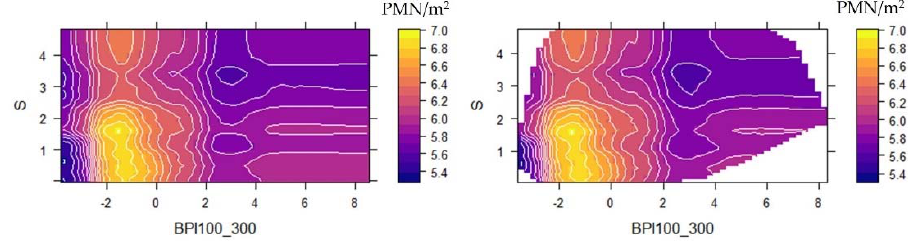
Figure A8. Shown are 2D PDPs between slope, BPI100_300, and PMN. Left: extrapolated feature space, Right: convex hull of the two variables and the none-described empty feature space. The interpretation outside of the convex hull is inadvisable.